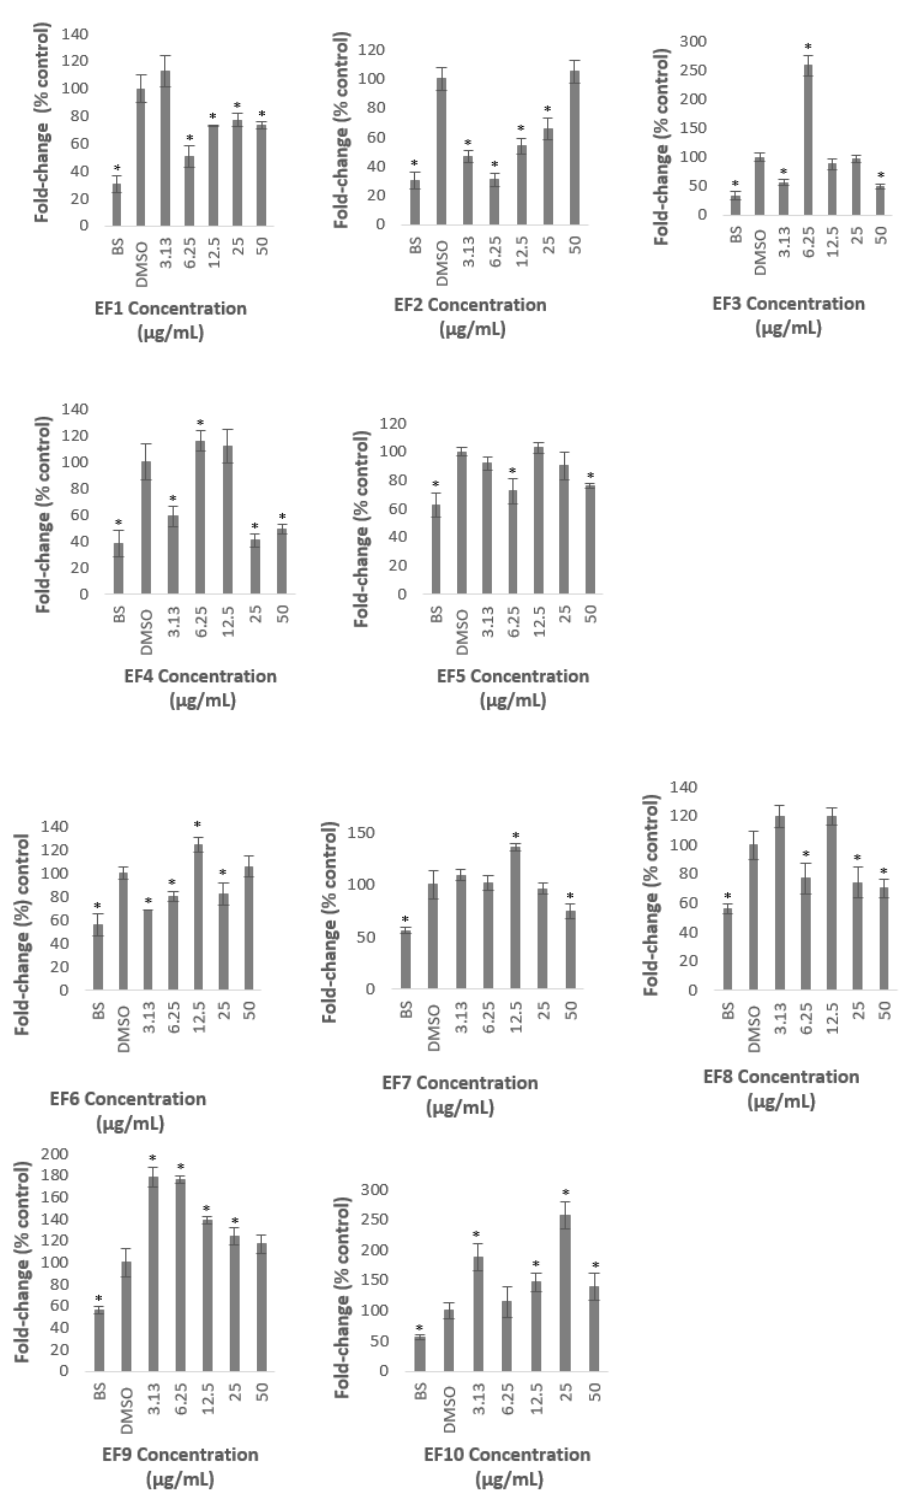
Figure 4. Luciferase activity of HepG2 cells transfected with PCSK9 promoter-reporter construct after 24 h treatment with A. planci fractions. The treatments were at five different concentrations from 3.13 to 50 µg/mL. Data presented as mean ± SD with n = 6. The value at each point represents the fold change of normalised PCSK9 promoter activity relative to the untreated control which is assigned as 100%. * denotes significantly different as compared to DMSO-treated cells (negative control) at p < 0.05. DMSO was used as the carrier to dissolve and dilute the extract.